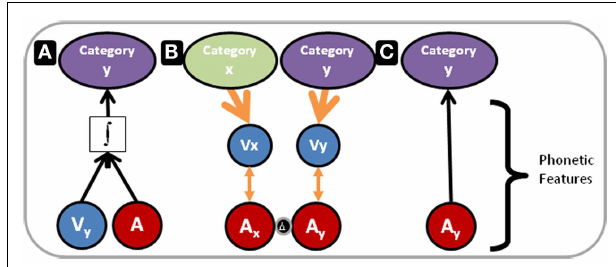
FIGURE 7 | Perceptual learning versus integration model. The blue and red circles in the lower part of Figure 7 represent visual and auditory phonetic speech features, respectively.These correspond to the mid level of processing in Figure 6 .The categories at the top of the figure correspond to representations at the high-level of processing in Figure 6 . (A) Depicts processing under conditions in which acoustic phonetic features alone are not sufficient to specify the phoneme category.The integrated audiovisual phonetic features do provide adequate information. Perceptual processing flows bottom-up, and remapping along the auditory pathway has not occurred. In contrast, (B) Depicts a reverse flow of information. As in (A) , Combined audiovisual information is sufficient to specify phoneme categories (not shown). However, here a reverse search is initiated. Higher-level visual speech categories, x and y , feed back to visual phonetic features, Vx and Vy , that use natural audiovisual correlations (orange double arrowed lines) to guide the search for relevant distinctions in acoustic-phonetic feature representations.The two red circles separated by a delta are labeled Ax and Ay because the acoustic phonetic features are now distinct. (C) Depicts auditory-only processing, following the perceptual learning depicted in (B) .The acoustic phonetic features alone are now sufficient to specify the phoneme